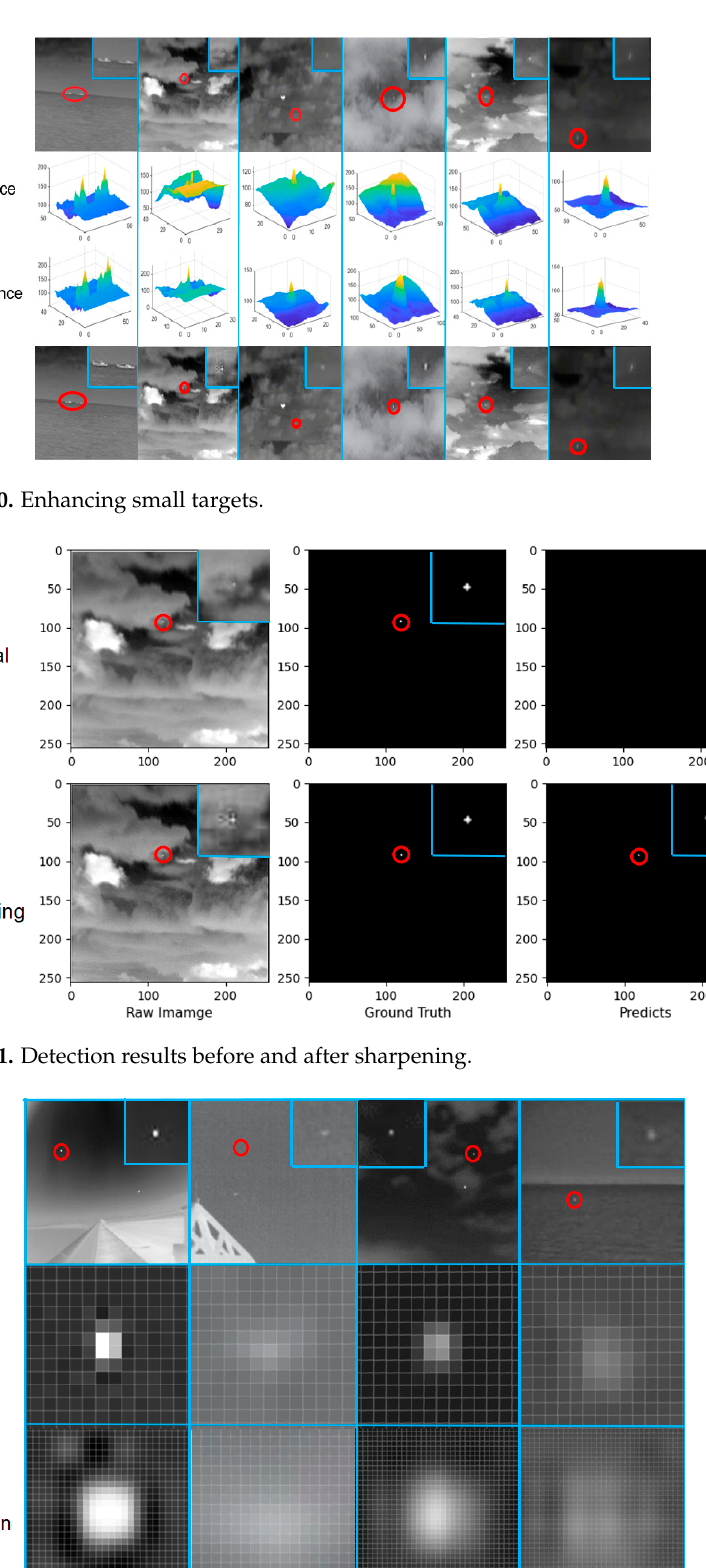
Figure 12. Experiment with expanded target pixels.